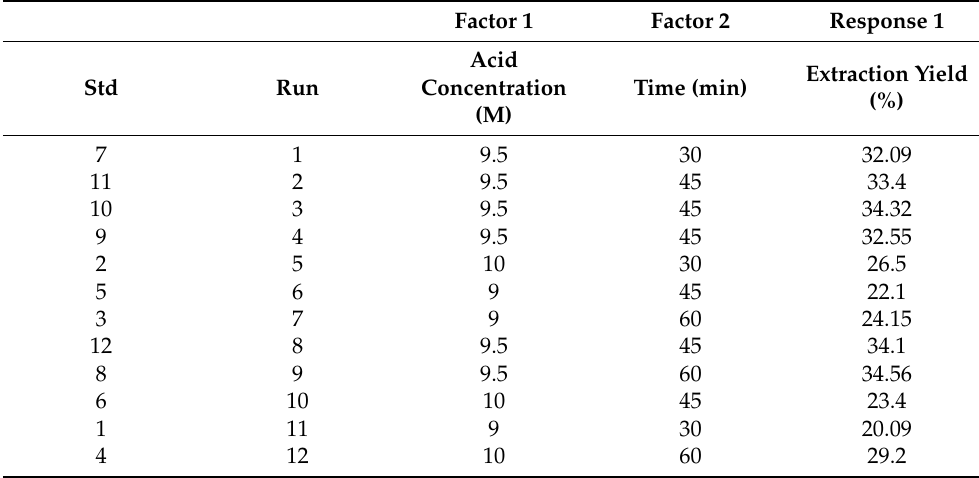
Table 2. Apricot pomace extract extraction yield (%) on RSM experimental